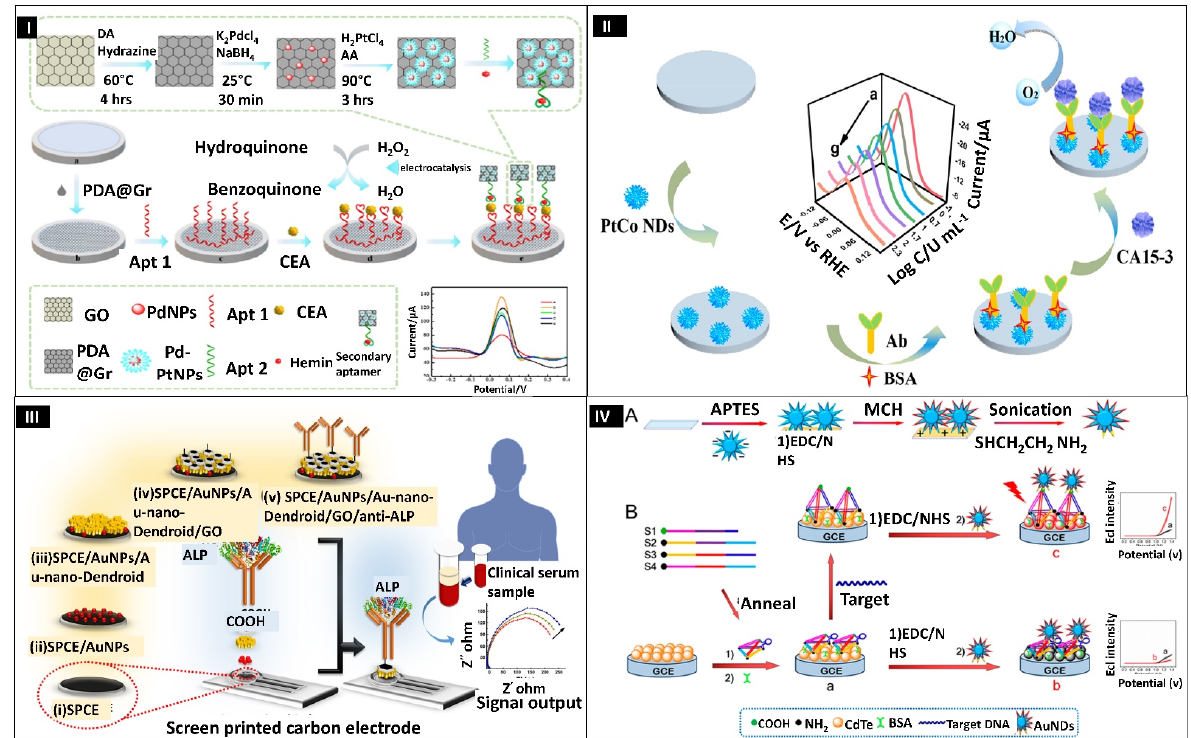
Figure 5. ( I ) Pictorial representation of the fabrication of aptasensor for detection of carcinoembryonic antigen. Reprinted with permission from [128]. Copyright 2021, Zhang et al. ( II ) Schematic representing the immunosensing of carbohydrate antigen 15-3 by bimetallic nanodendrites PtCo. Reprinted with permission from [129]. Copyright 2021, Ge et al. ( III ) Illustration depicting the preparation of SPCE/AuNPs/Au-nanodendroids/GO/anti-ALP sensor for detection of alkaline phosphatase (ALP). Reprinted with permission from [95]. Copyright 2020, Mahato et al. ( IV ) ( A ) Schematic denoting the step-by-step modification of surface, ( B ) Illustration showing the gold nanodendrites-based electrochemiluminescence sensor for nucleic acid detection. Reprinted with permission from